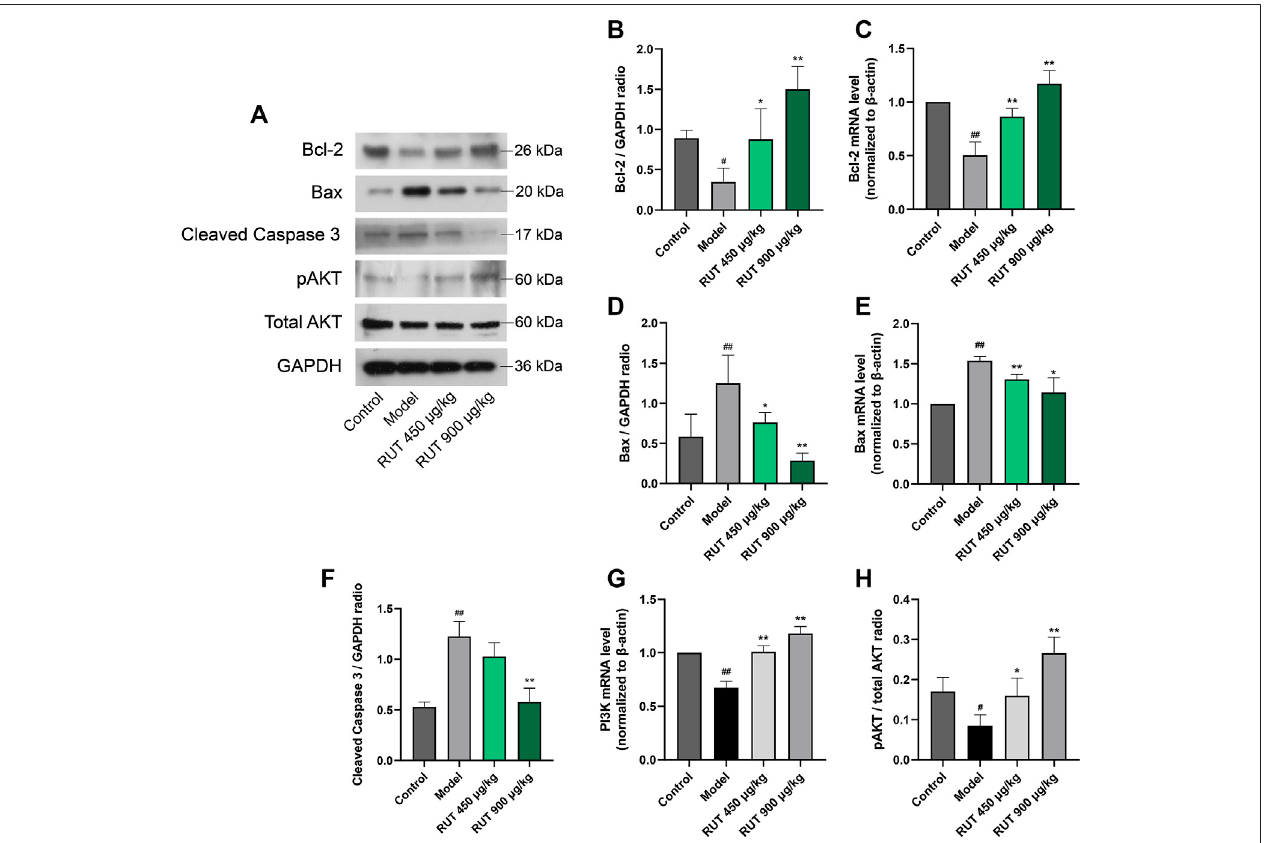
FIGURE6 | Effect ofRUT on apoptosis factors levels and PI3K pathway ingastric damage inducedby ethanol. Note: (A) Western blotimages ofBcl-2, Bax, pAKT and totalAKT; (B) Bcl-2protein level; (C) Bcl-2mRNA level; (D) Baxprotein level; (E) BaxmRNAlevel; (F) TissueCaspase9level; (G) Caspase3mRNAlevel; (H) Tissue Caspase 3 level; (I) PI3K mRNA level. (J) pAKT protein level; Values are expressed as mean ± SD (n (cid:1) 6). # p < 0.05 and ## p < 0.01 when compared with the control group. * p < 0.05 and ** p < 0.01 when compared with the model